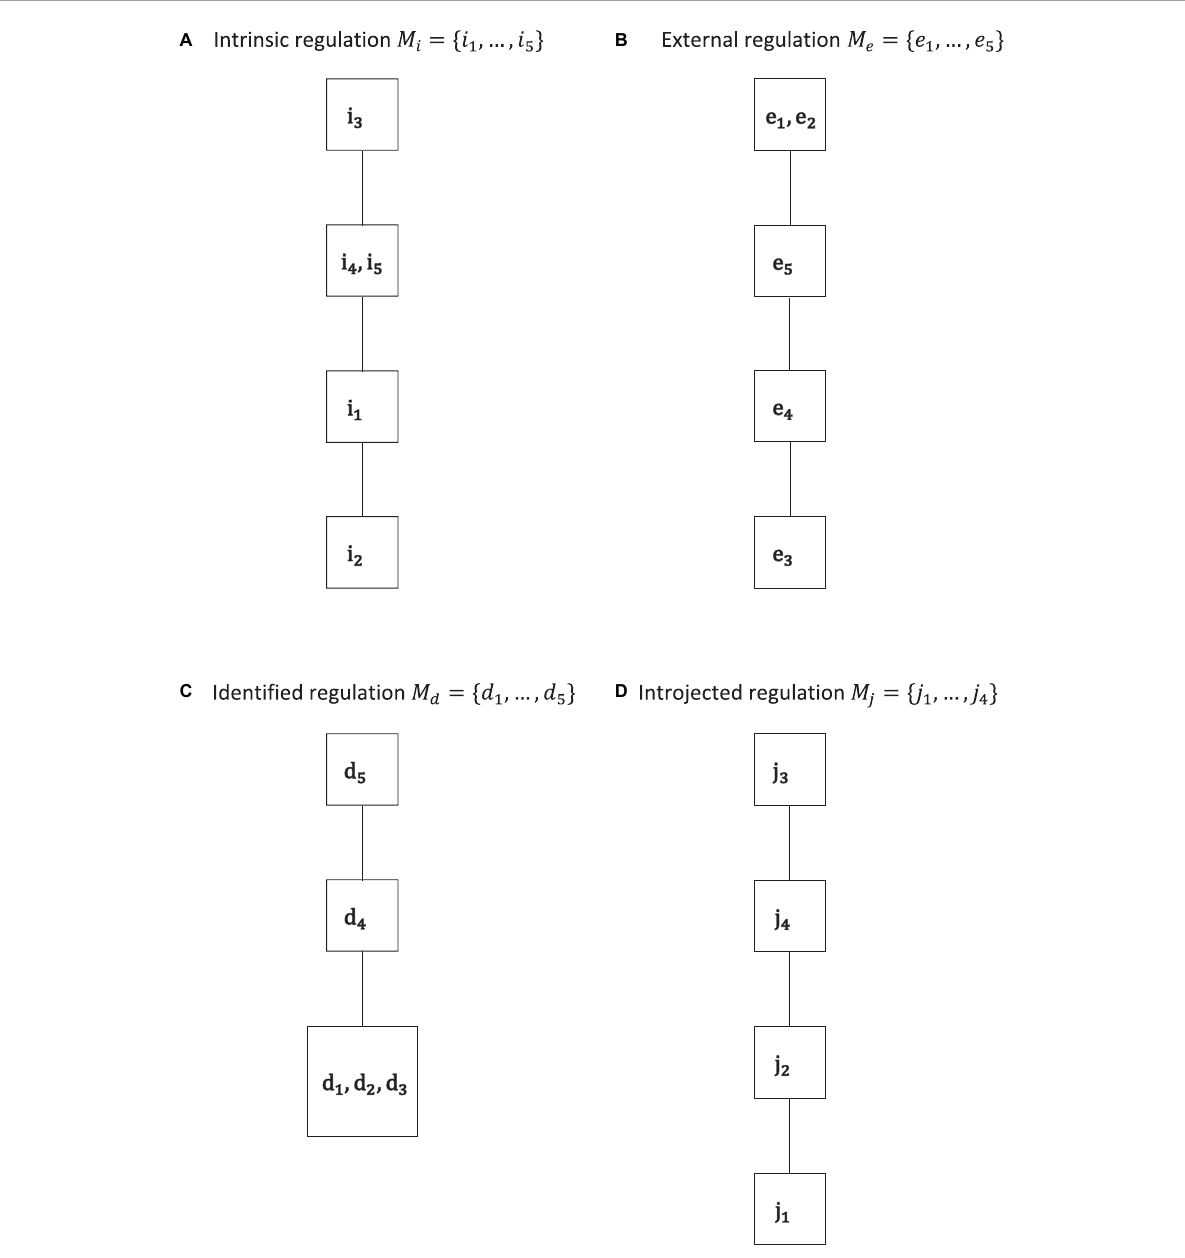
FIGURE3 Motivation co-occurrence relations obtained by IITA of the empirical data set for the types of intrinsic regulation (A) , external regulation (B) , identified regulation (C) , and introjected regulation (D) . In each type, we see gradations that are cumulative, in the sense that they form linear orders or chains. Except for introjected regulation, there are equally informative